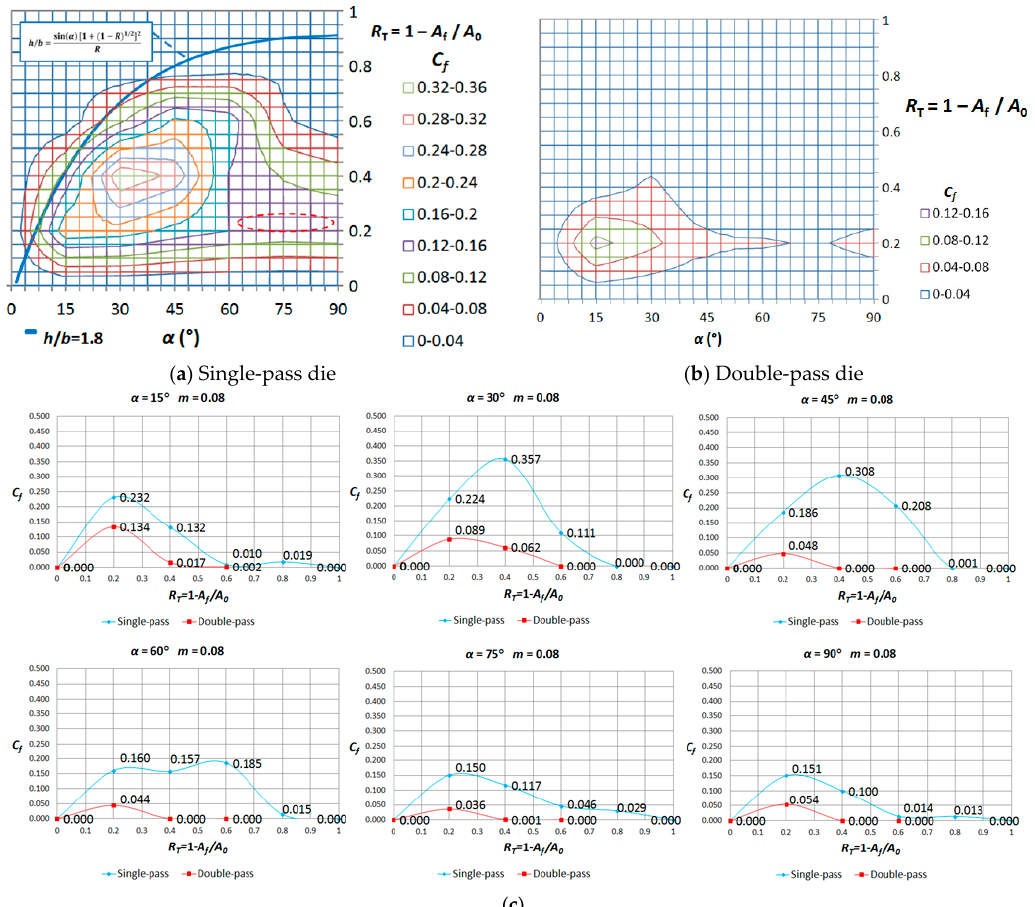
Figure 18. Comparison of minimum damage ( C f ) induced with ( a ) single-pass dies vs. ( b ) double pass dies in cold extrusion of dual-phase steel DP800. ( c ) Values of minimum damage factor reached for all the combinations of die semiangle and total reduction for single and double-pass dies.